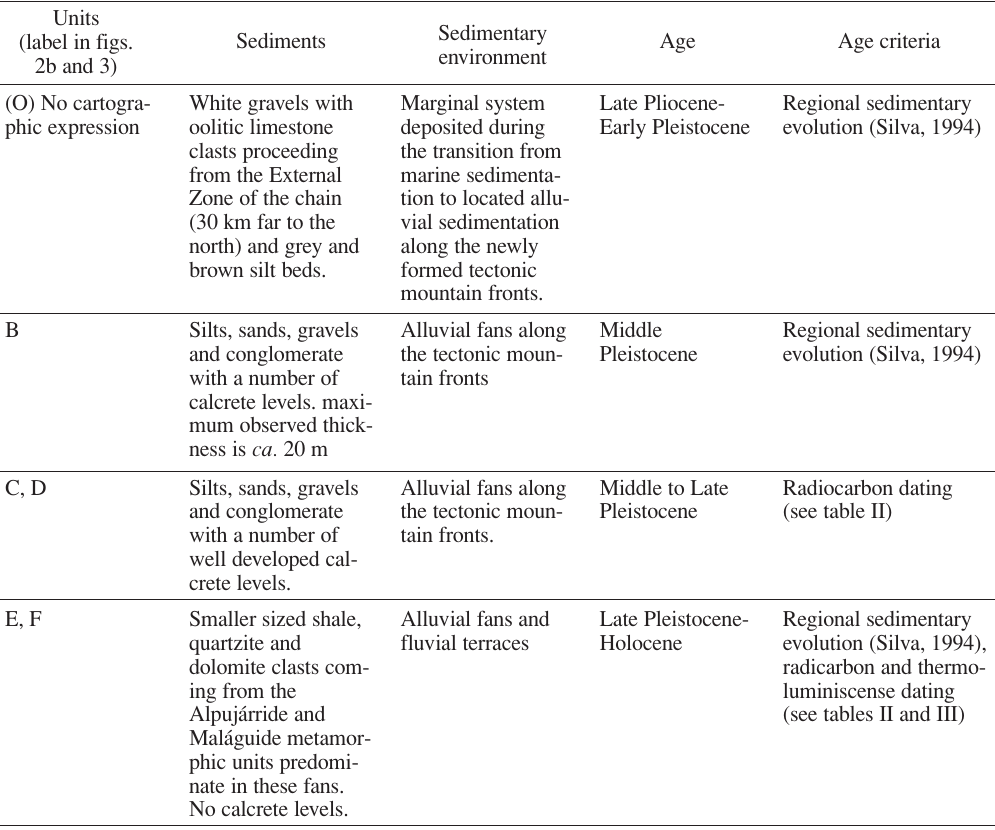
Age Age criteria